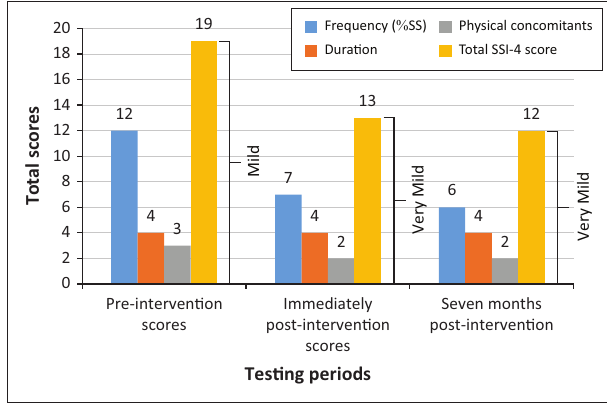
FIGURE 2: Total scores of the Stuttering Severity Instrument-Fourth Edition: Frequency, duration, physical concomitants and severity rating at three testing